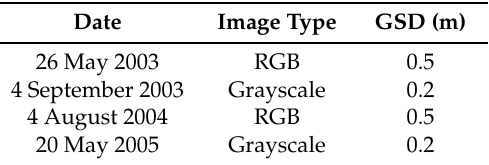
Table 1. Summary of the orthoimagery dataset used in this work. RGB indicates true color images, while grayscale are panchromatic. GSD stands for ground sample distance presented in meters (m).